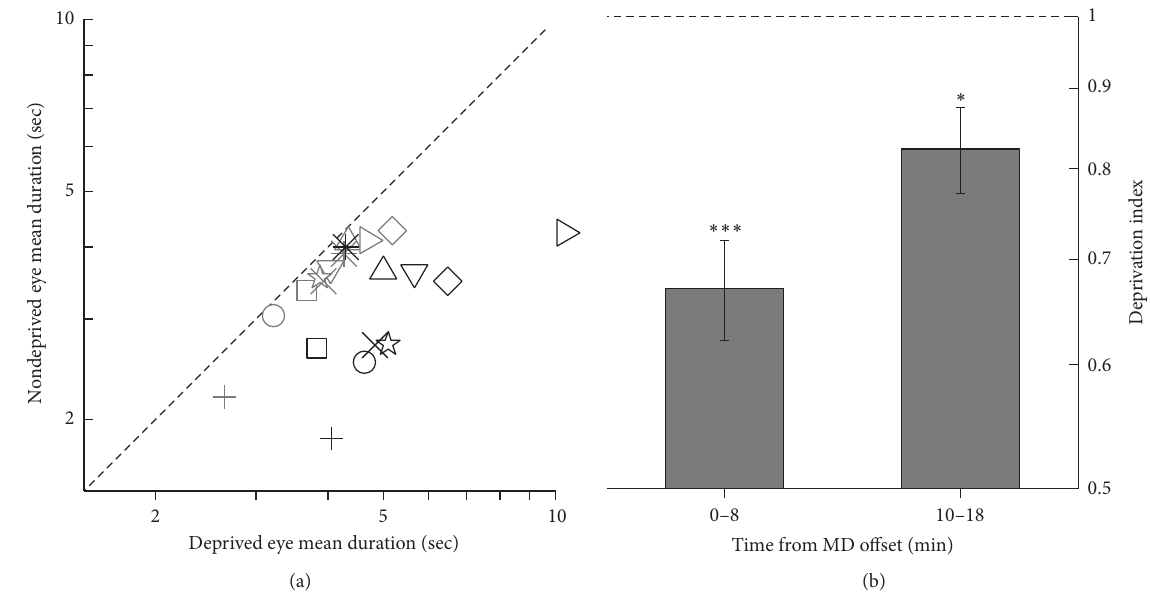
Figure 3: Binocular rivalry results. (a) Scatter plot of the individual subjects’ mean phase durations for the deprived and nondeprived eye obtained before (light grey symbols) and during the first 8 minutes after monocular deprivation (black symbols). (b) Deprivation Index (see (1) in Methods) summarizing the increase in deprived eye-predominance for the first 8 minutes after eye-patch removal and for the interval between 10 and 18 minutes after deprivation. The Deprivation Index value of 1 (designated by the dashed line) would indicate no change in ocular dominance after deprivation; values smaller than one indicate increased deprived eye-predominance. Error bars represent 1 ± s.e.m.; asterisks represent statistical significance ( ∗∗∗ 𝑝 < 0.001 , ∗ 𝑝 < 0.05 ).